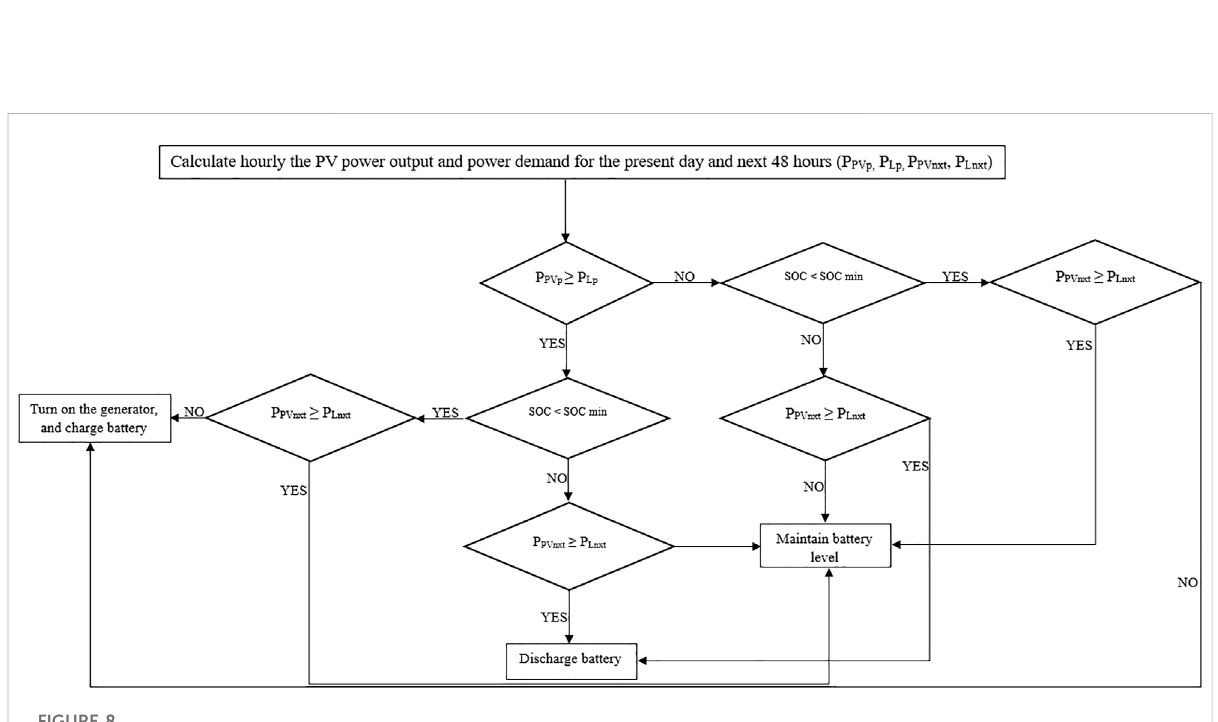
FIGURE 7 Flow chart for CC strategy.